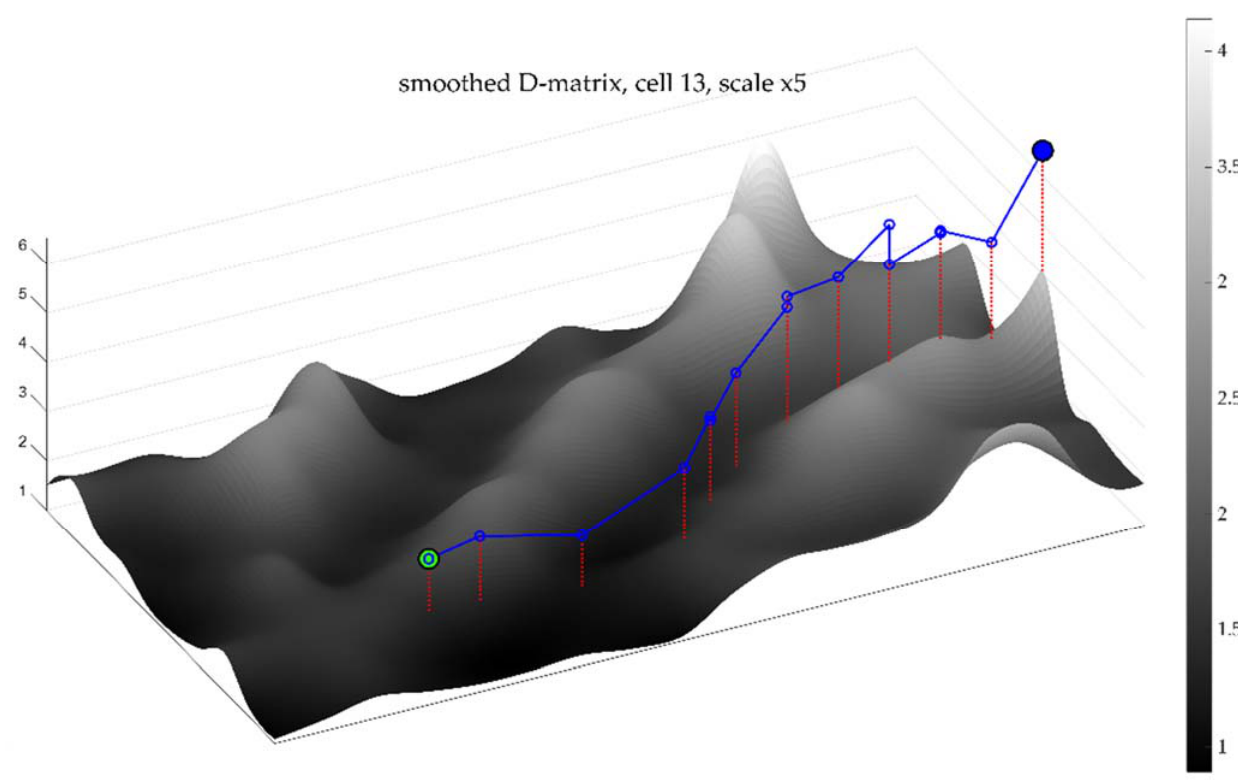
Figure 14. D visualization of the D-matrix and trajectory for cell 13 (cell first cycle is displayed in green).